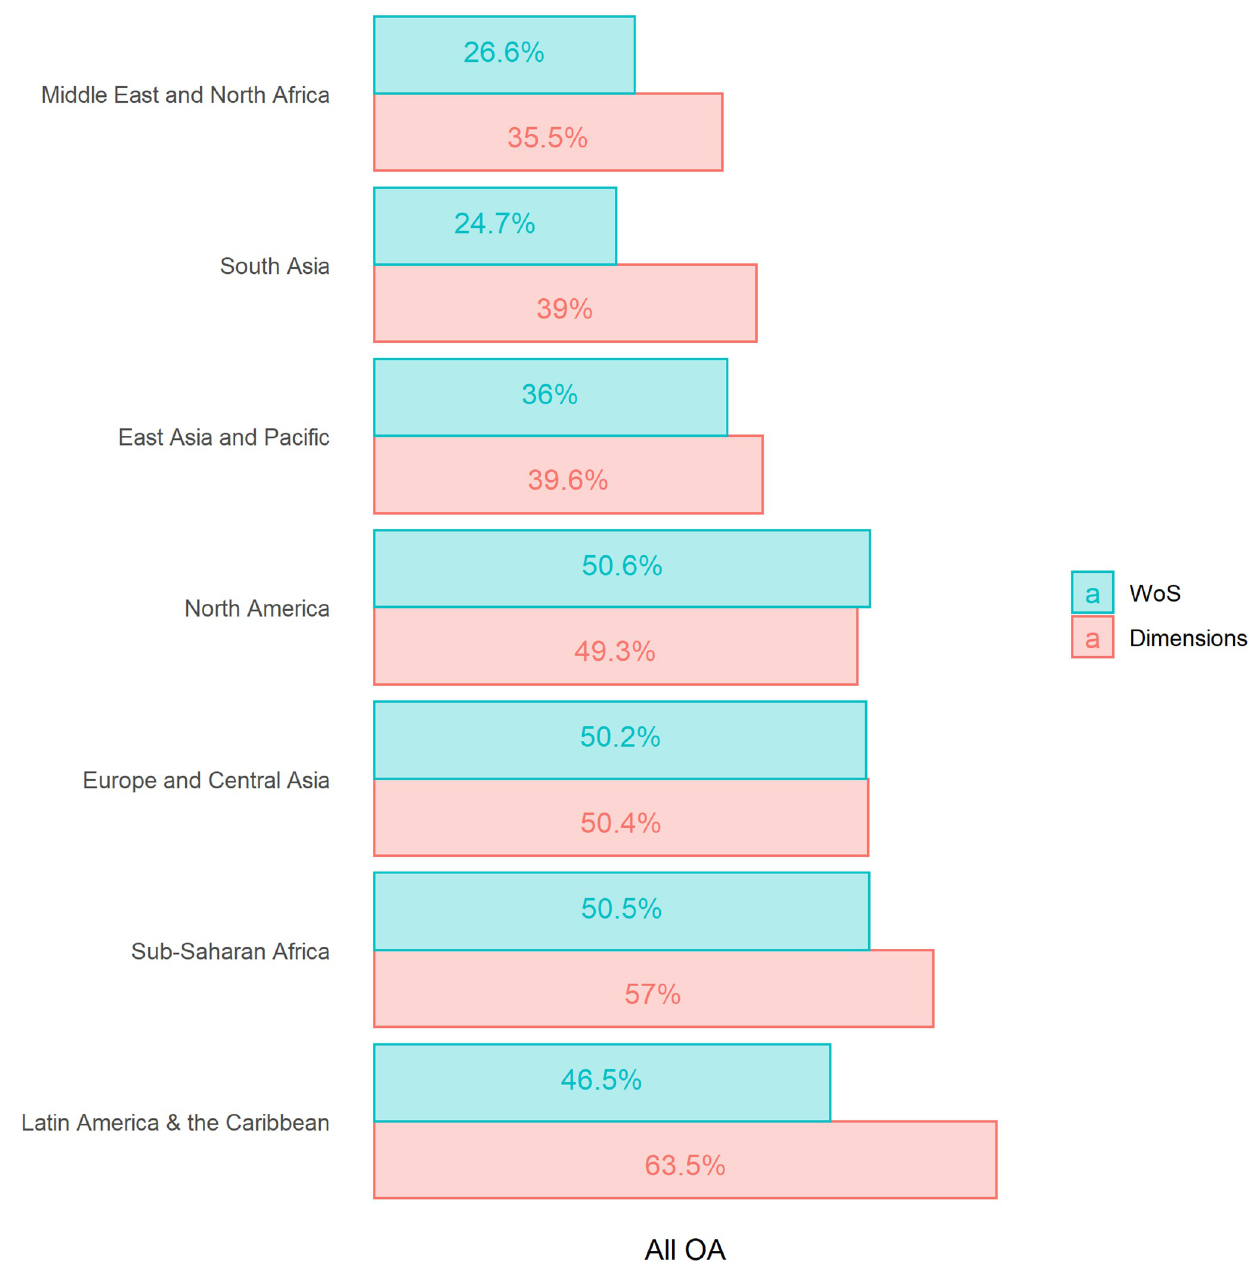
Fig 2. Percentage of open access publications, by region and database,